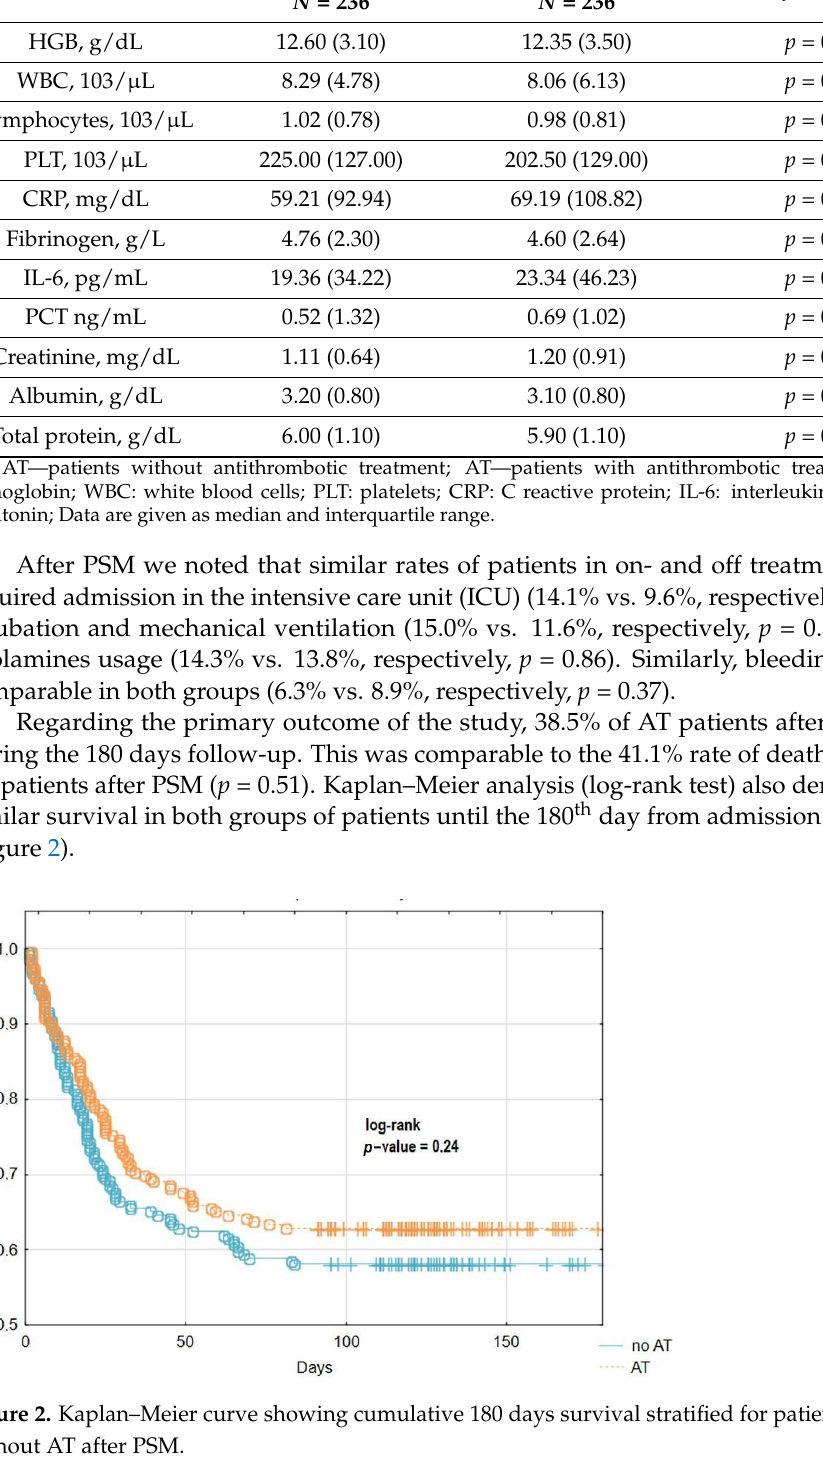
DOACs therapy (Figure